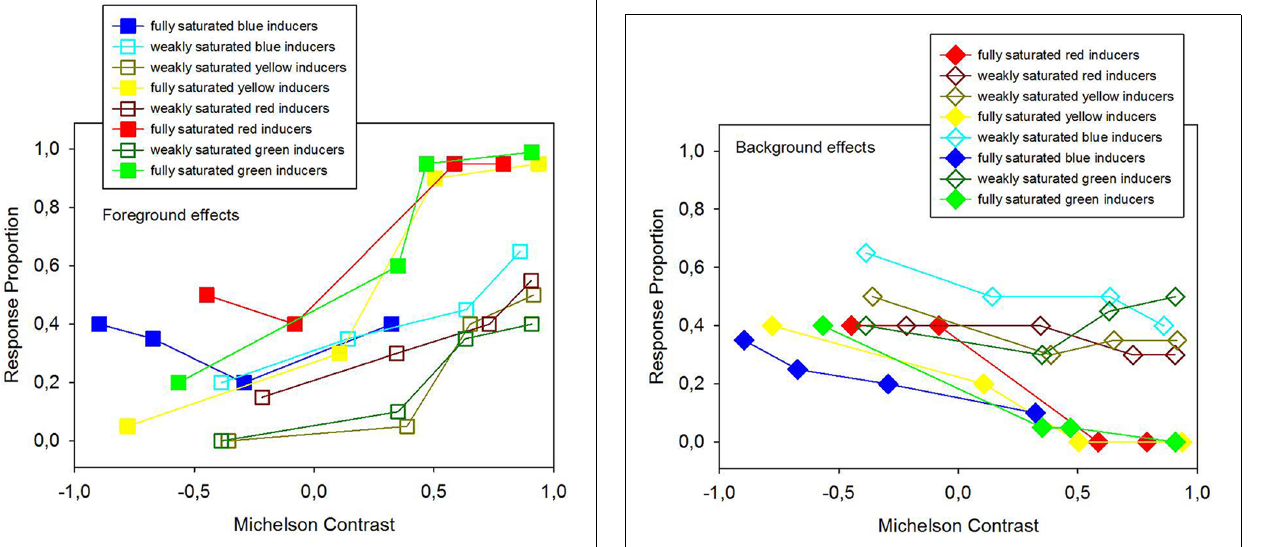
FIGURE 7 | Average response proportions of foreground effects, indicating that the colored inducers were seen as figure, as a function of hue, Michelson contrast and saturation levels of the colored inducers. 2 × 2 ANOVA signaled a statistically significant effect of saturation (analysis 3) on foreground effects, where fully saturated inducers produce stronger figure percepts than weakly saturated inducers, as shown here in the graph.